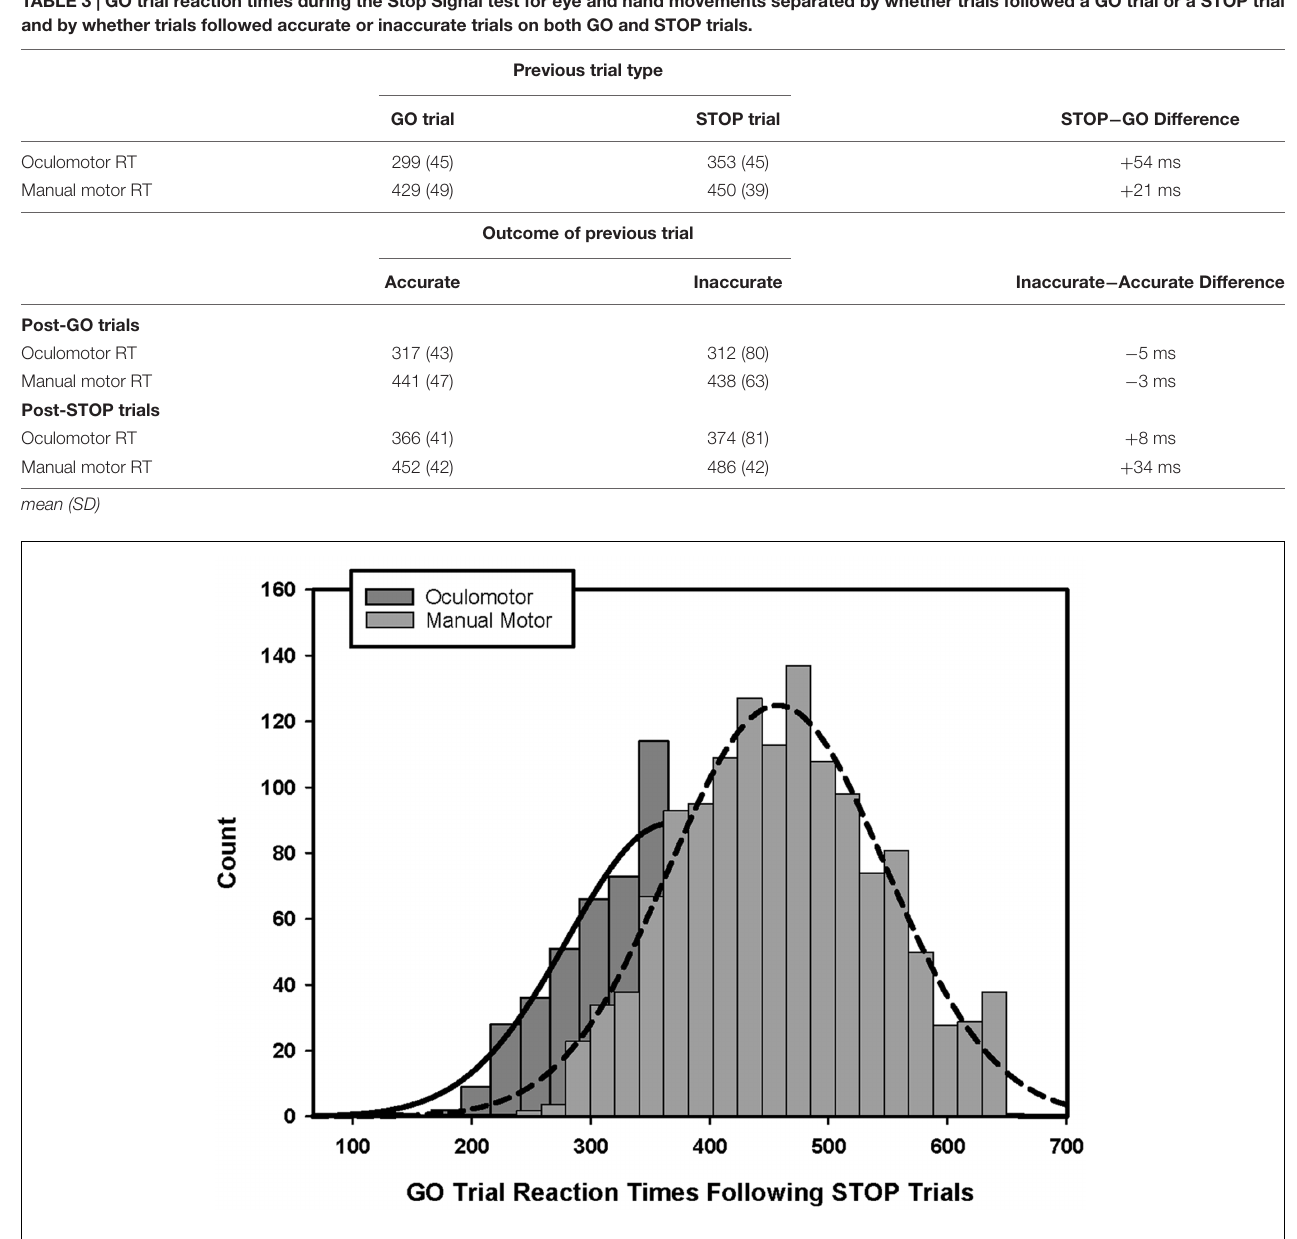
Frontiers in Psychology |